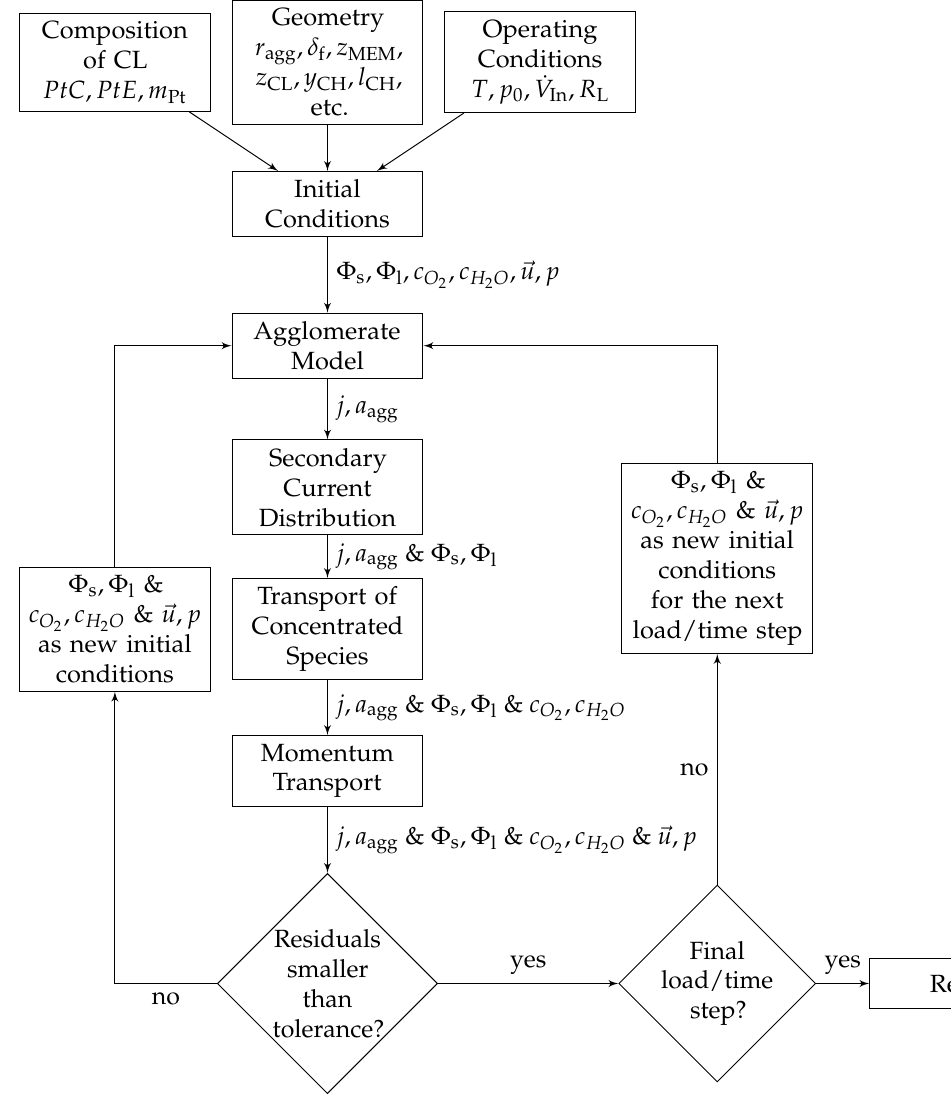
Figure 7. Exemplary solution process for the